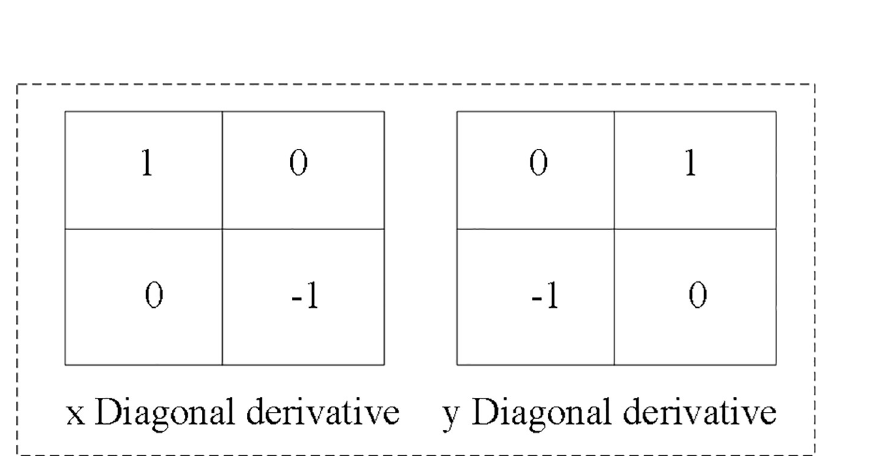
Fig 3. Roberts edge detection